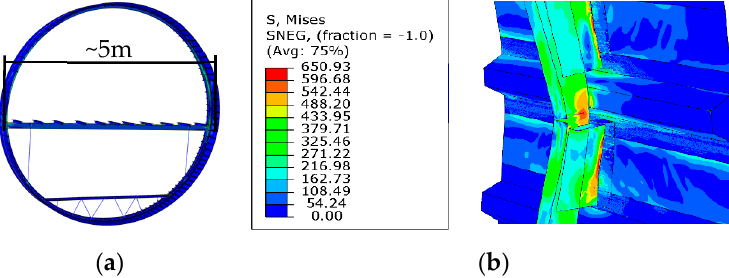
Figure 10. Structural model in detail: ( a ) Slice of the medium-detailed FE model (green region); ( b ) Damage FE model of a frame subjected to a bending moment.